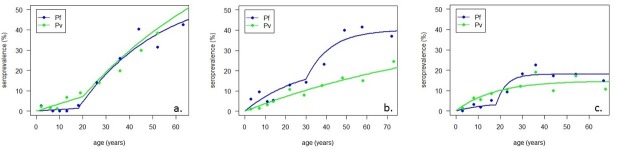
Seroprevalence curves for each location used to calculate SCRS (λ).a. Pulau Banggi, Sabah (Pf λ1: 0.0196 (0.0078–0.0492); Pf λ2: 0.0008 (0.0002–0.0031); Pv λ1: 0.0185 (0.0136–0.0248)) b. Matunggong, Kudat ((Pf λ1: 0.0588 (0.0198–0.1746); Pf λ2: 0.0085 (0.0063–0.0116); Pv λ: 0.0039 (0.0024–0.0064)) c. Bacungan, Palawan (Pf λ1: 0.1441 (0.0175–1.1892); Pf λ2: 0.0031 (0.0012–0.0086); Pv λ: 0.0086 (0.0044–0.0166)).